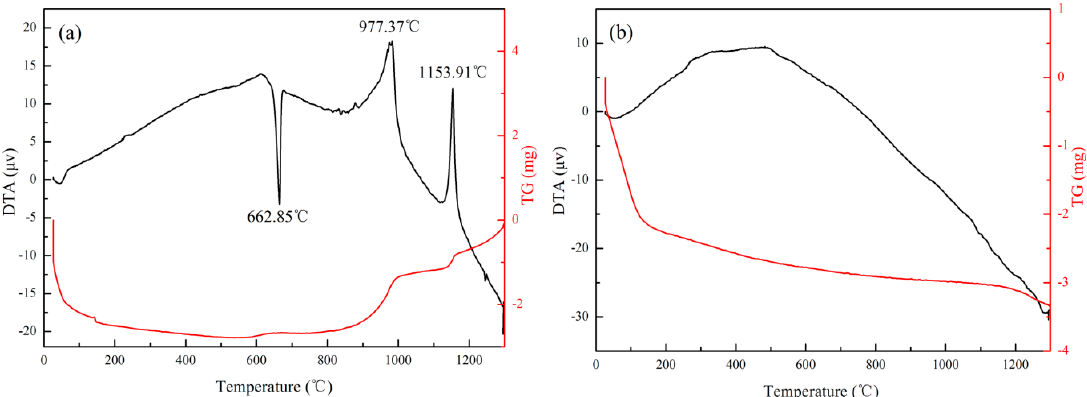
Figure 8. TG-DTA curves of ( a ) ASMA and ( b ) AS. Coatings 2019 , 9 , x FOR PEER REVIEW